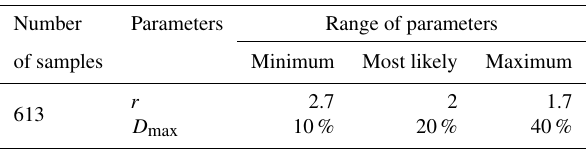
Table 1. Number of samples and range of r and D max values, cal- culated by the bootstrap and chi-square test of goodness of